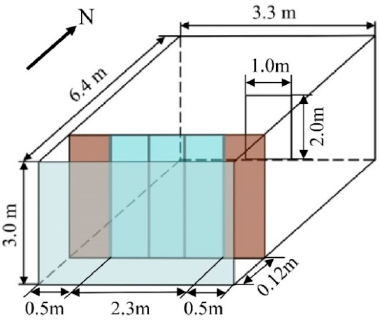
Figure 5. Test room of the dormitory building.